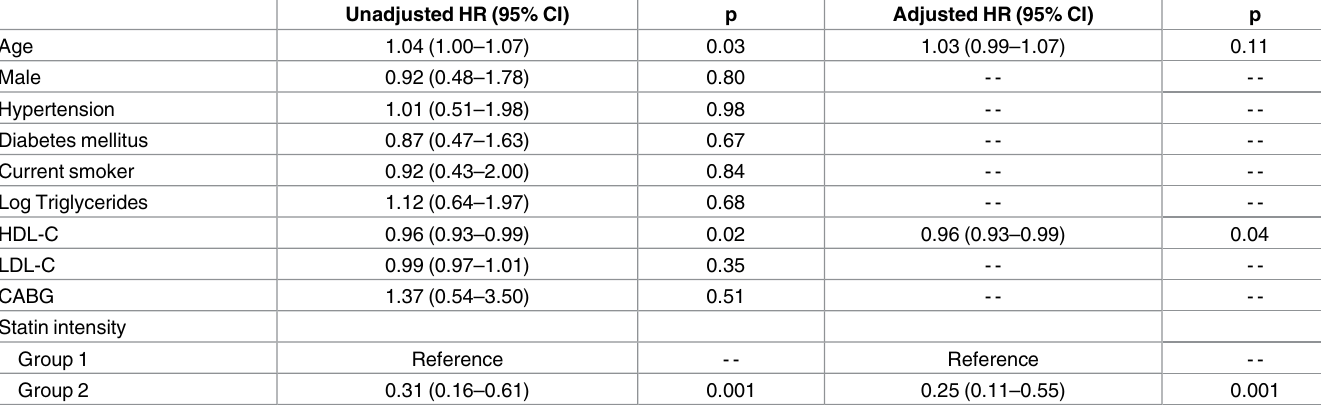
Table 4. Determinants of MACE according to Cox proportional hazard